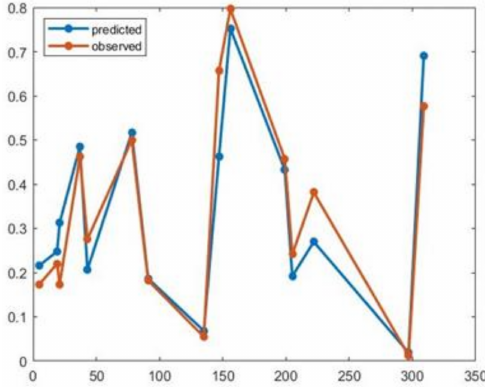
Figure 10. Model predictions vs. observed